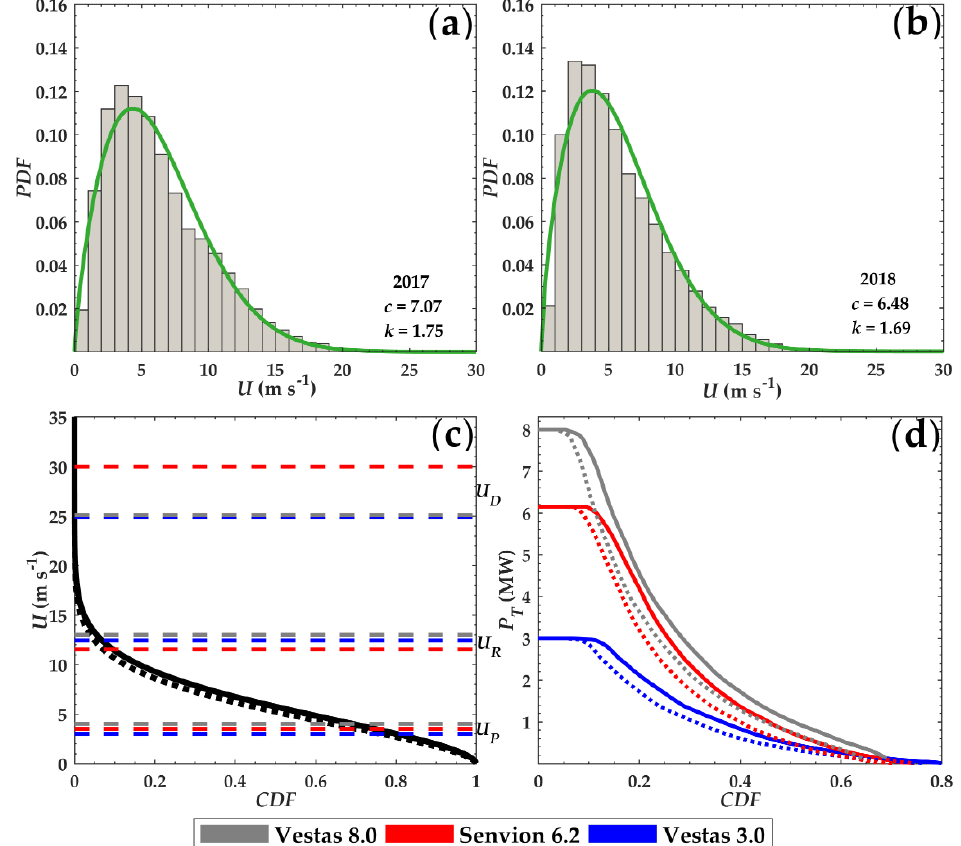
Figure 5. Histogram distribution of wind speed U (gray columns) measured by LIDAR at a height of 110 m for 2017 ( a ) and 2018 ( b ). The solid green line represents the Weibull probability distribution functions ( PDF ) fitted to the data. ( c ) Wind speed Weibull cumulative distribution functions ( CDF ) at a height of 110 m. The dashed lines represent the cut-in speed U P , rated speed U R , and cut-out speed U D for each turbine (Table 1). ( d ) Power cumulative distribution functions for Vestas 8.0, Senvion 6.2, and Vestas 3.0 turbines. In panels ( c ) and ( d ) the year 2017 is represented by solid lines and 2018 by dashed lines.